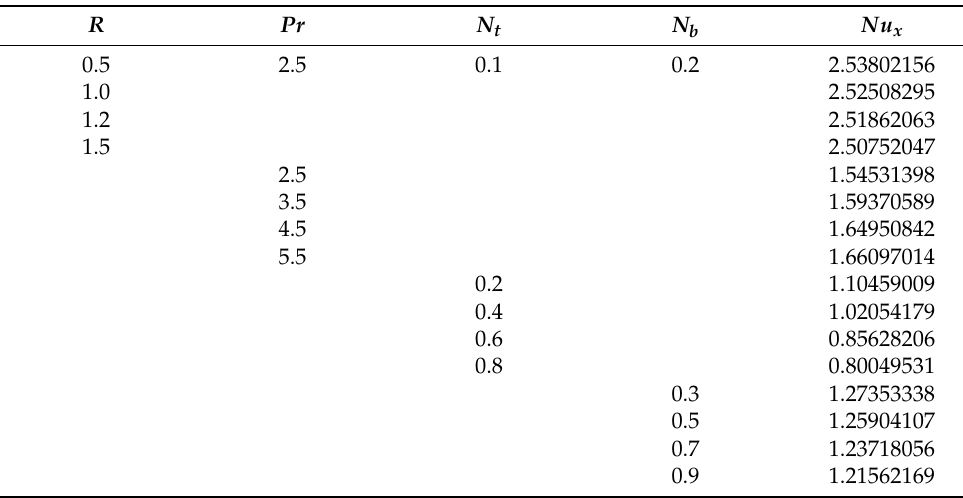
Table 3. Numerical outcomes of Nu x for R , Pr , N t , and N b .